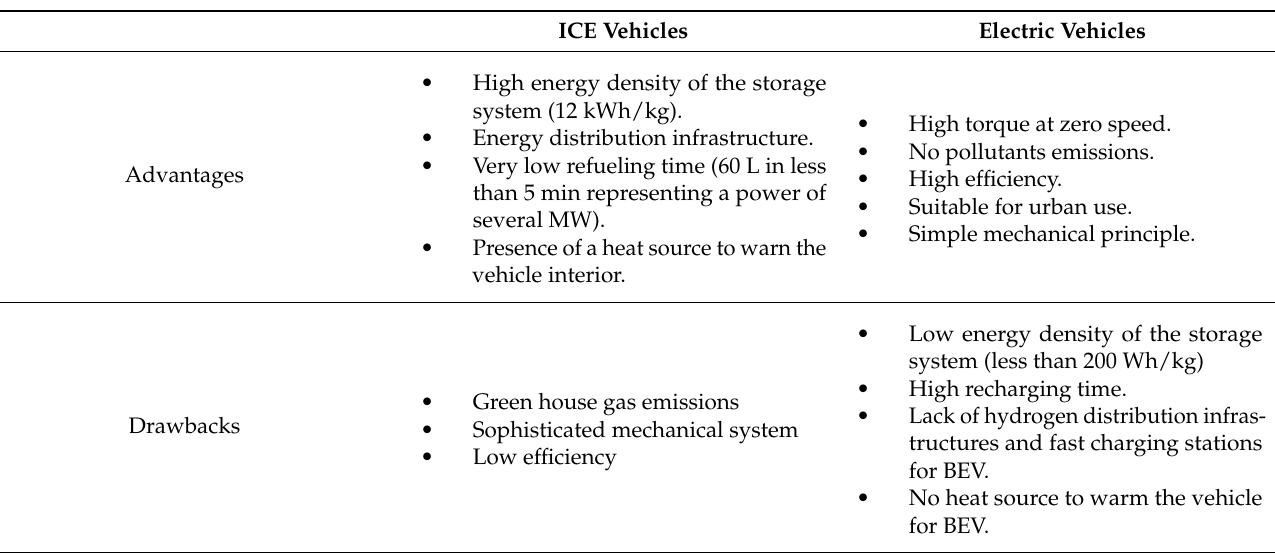
Figure 5. Electric vehicles classification. Table 2. Comparison of ICE vehicles and electric